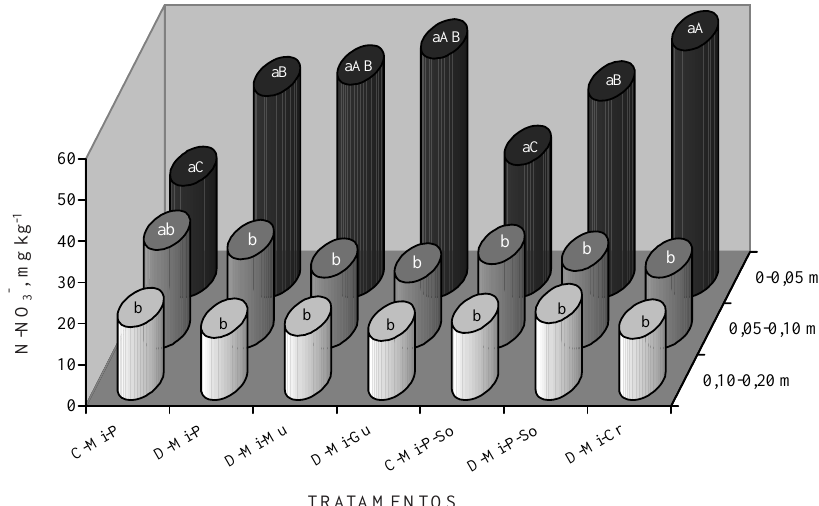
Figura 1. Nitrogênio potencialmente mineralizável em um Latossolo Roxo cultivado em diferentes sistemas de produção por seis anos consecutivos. Letras maiúsculas comparam valores entre tratamentos e letras minúsculas, entre profundidades. C = sistema de semeadura convencional; D = sistema de plantio direto; Mi = milho semeado no verão; So = soja semeada no verão; P = pousio no inverno; Mu = semeadura de mucuna-preta no inverno; Gu = semeadura de feijão guandu no inverno; Cr = semeadura de Crotalaria juncea no